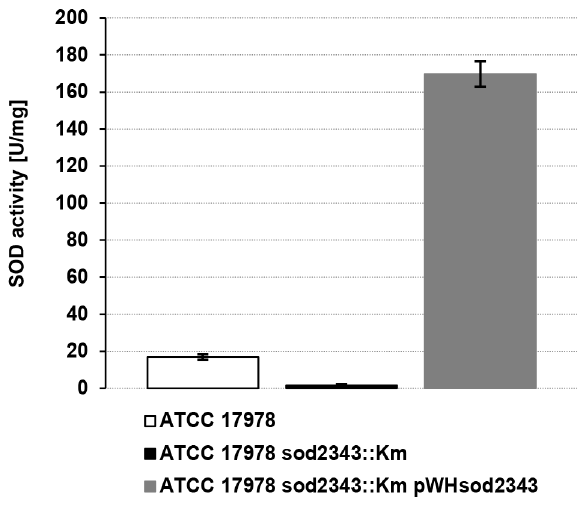
Figure. 2. SOD activity assay reveals a minor residual activity of the ATCC 17978 sod2343::Km mutant and an overproduction of SOD2343 in the complemented strain compared to the parental one. OD-adjusted suspensions of indicated strains cultivated overnight were disrupted and after centrifugation cleared lysate supernatants were directly used for SOD activity assays as outlined in the Materials & Methods section. For each strain, data obtained from three independent cultures were averaged; error bars represent plus/ minus one standard deviation. (Figs. S2 and S3). In accordance with the results obtained with whole cell lysates, the amount of SOD2343 protein detected in the culture supernatant of complemented mutants was considerably above the level found in the supernatant of parental strains (Fig. S3).